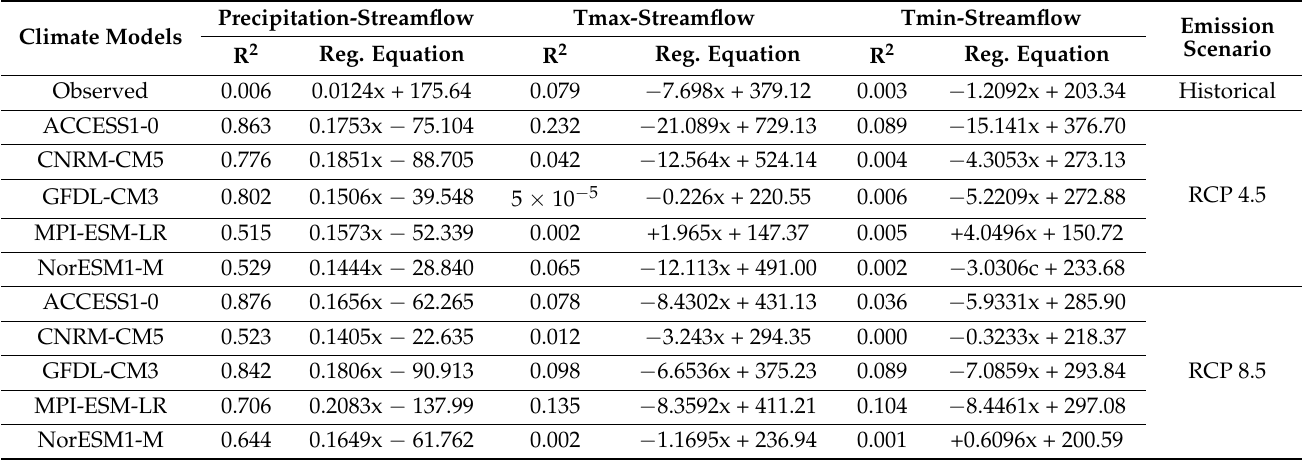
Table 5. Coefficient of determination (R 2 ) and governing regression equation to establish the relationship between precipita- tion, maximum temperature (Tmax), minimum temperature (Tmin) and